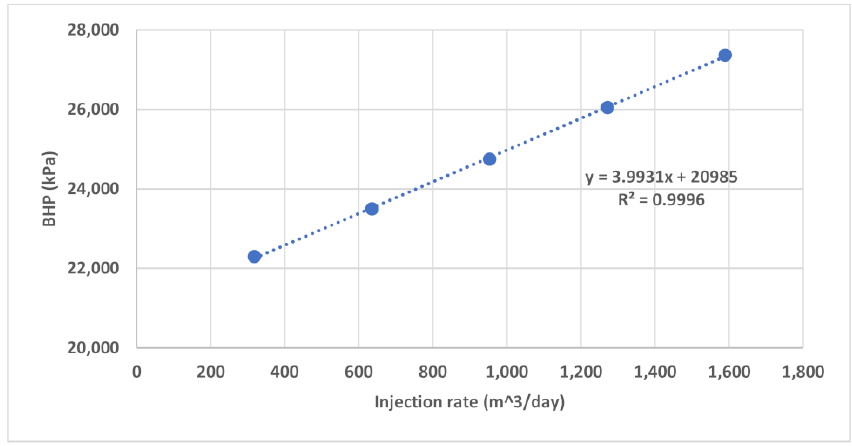
Figure 16. Segment of water injection baseline used for BHP analysis with rate steps.